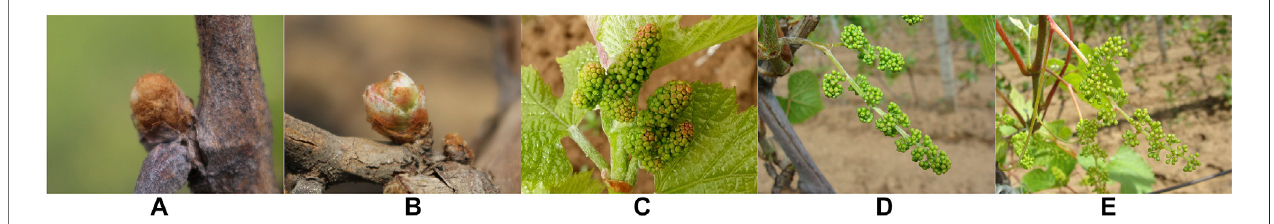
FIGURE1| Five developmental stages ofbudsor fl owers ofmale V.amurensis .Females and hermaphrodites(not shown)resemble males inthese developmental stages. (A) Wooly bud. (B) Green tissue visible. (C) Flower buds aggregated. (D) Aggregated fl ower buds in separated branches. (E) Flower buds separated; ready to